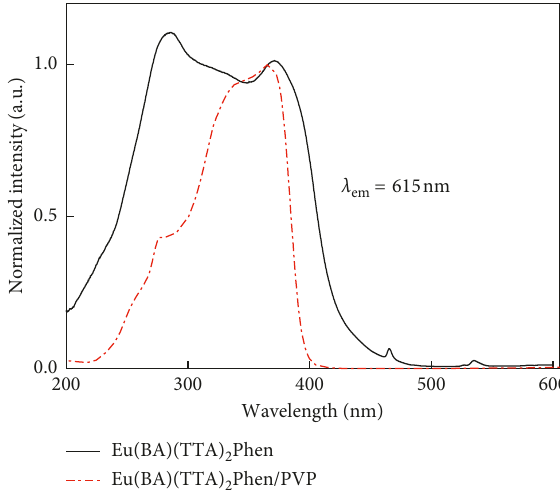
Figure 6: Normalized excitation spectra of Eu(BA)(TTA) and Eu(BA)(TTA) 2 Phen/PVP.